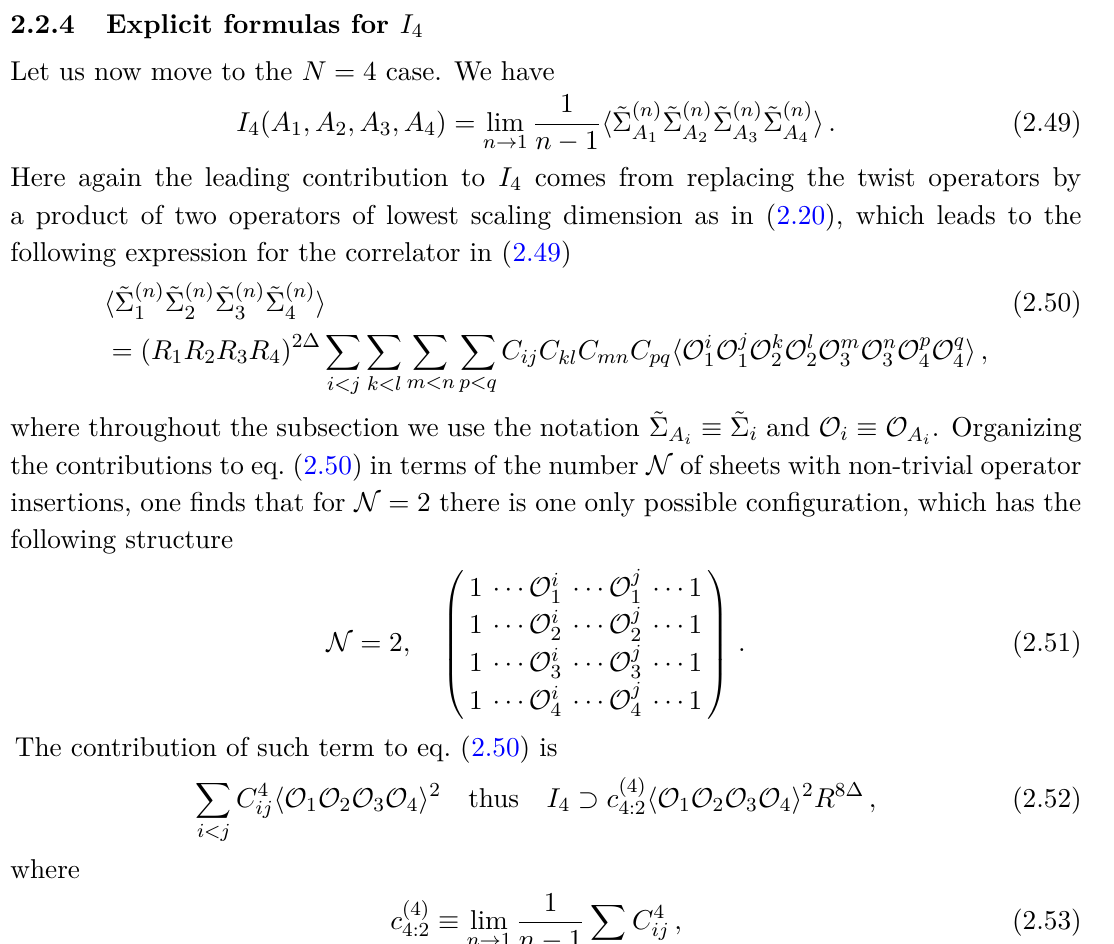
Figure 2 . Graph representation of the two types of terms contributing to the I 3 at long distances. Both contributions are represented via totally connected diagrams, as expected from